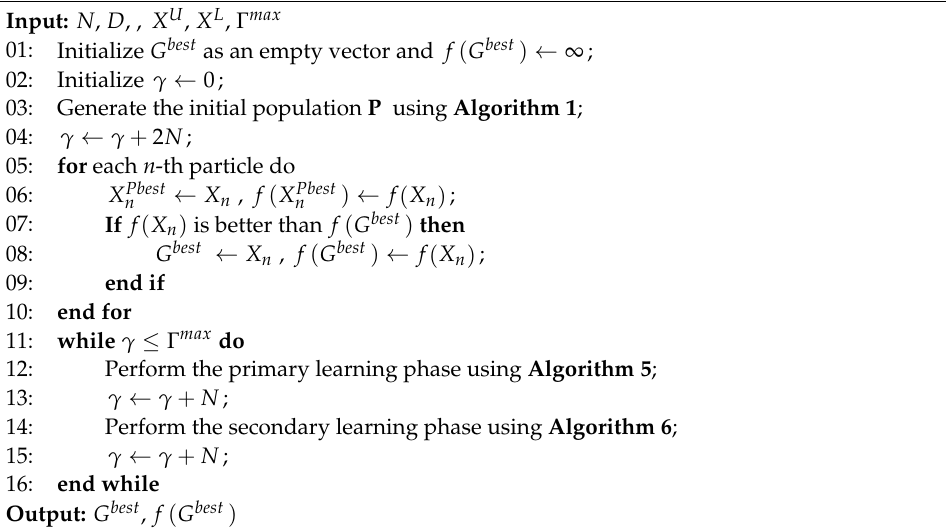
Algorithm 7 (Main Algorithm).